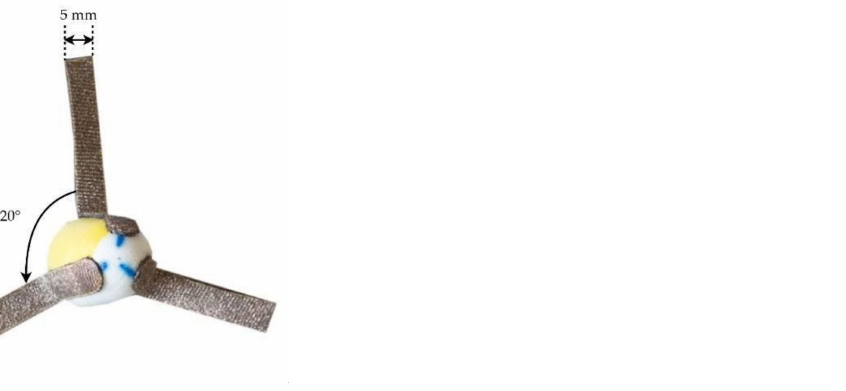
Figure 1. Foam earplug earpieces with three electrodes located at 120 ◦ apart of sizes 8 × 5 mm (area: 40 mm 2